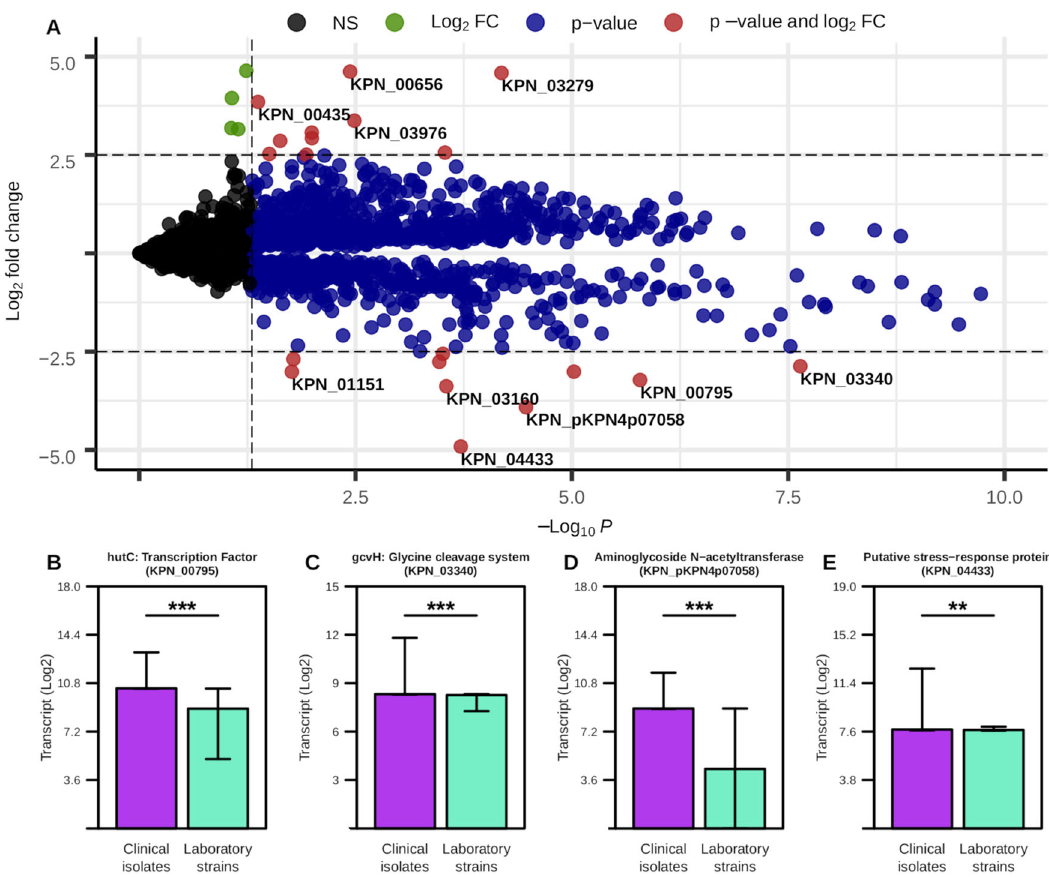
Fig. 1 Transcriptional differences between laboratory and clinical isolates of K. pneumoniae . A Differential expression analysis with Log 2 fold change cutoff = 2.5, p -value cutoff = 0.05. Genes with highest degree of difference are labeled. Each point is an individual gene and the color of the point corresponds to whether or not the Log 2 fold change is not signi fi cant (black, NS), has a Log 2 fold change > 2.5 (green, Log 2 FC), has a p -value < 0.05 (blue, p -value), or a Log2 fold change > 2.5 and a p -value < 0.05 (red, p -value and log 2 FC). B – E Median and interquartile ranges for select genes based on previous analysis. Signi fi cant differences determined by Wilcoxon rank-sum test with Benjamini – Hochberg correction (*** p -value ≤ 0.001, ** p -value ≤